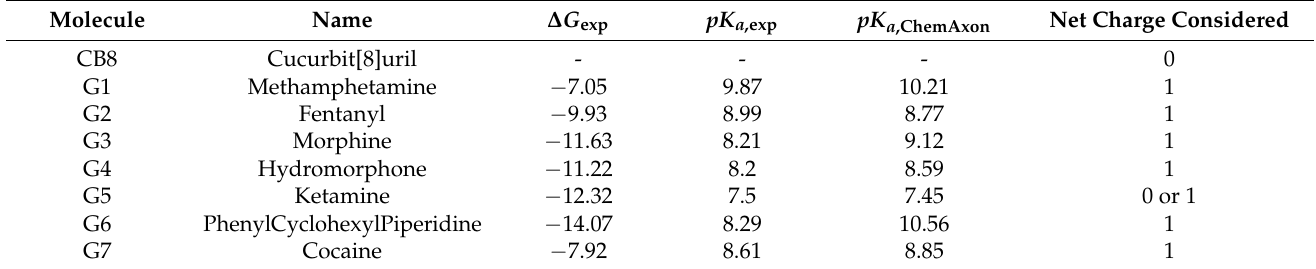
Table 2. The names of the CB8 host and 7 drugs/guests, the experimental binding affinities in kcal/mol, the pKa values of all guests determined experimentally at 298 K and via ChemAxon, and the net charges considered in the current work. The net charge of each molecule is determined by the relative magnitude of its pKa and the experimental condition (pH 7.4) that the binding thermodynamics is measured. The experimental and ChemAxon predicted values of all guests except G5 (Ketamine) are obviously larger than the experimental condition pH 7.4. Thus, all of them are protonated at the nitrogen atom in our modelling. As for guest G5, both the experimental and the ChemAxon results indicate the existence of acid-base equilibria. Thus, both the protonated and deprotonated forms are